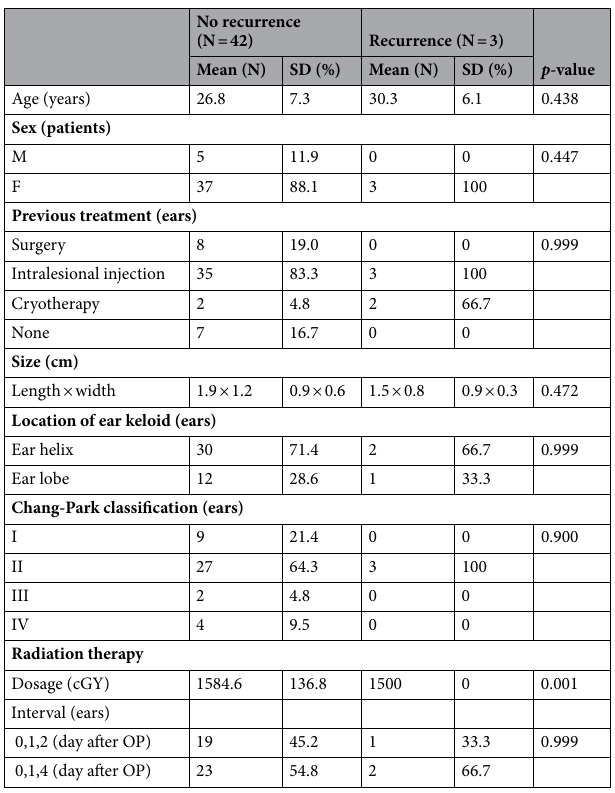
Table 3. Risk factors of keloid recurrences. F female, M male, N number, OP operation, SD standard